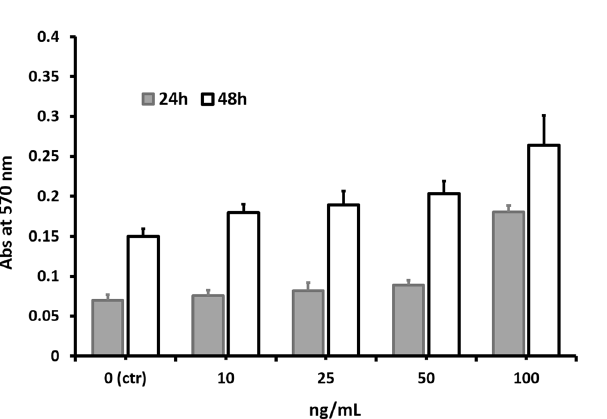
Figure 6. Cytotoxicity activity. ( a ) Characteristics of fibroblast cells, micrographs are shown at × 10 magnification. Scale bar 20 µm. ( b ) In vitro cytotoxicity study on fibroblast cells (10,000 cells/well) at 24, and 48 h. EGF corresponds to soluble epidermal growth factor, CNBr-EGF and Glyoxyl-EGF7 same as EGF immobilized on CNBr-activated-agarose (at pH 7) and glyoxyl-agarose, respectively. Untreated cells have been used as negative control (ctr, 0 ng/mL). A probability value less than 0.05 (*p < 0.05) was defined to be significant and 0.01 (**p < 0.01), 0.001 (***p < 0.001), 0.0001 (****p < 0.0001) as highly significant.